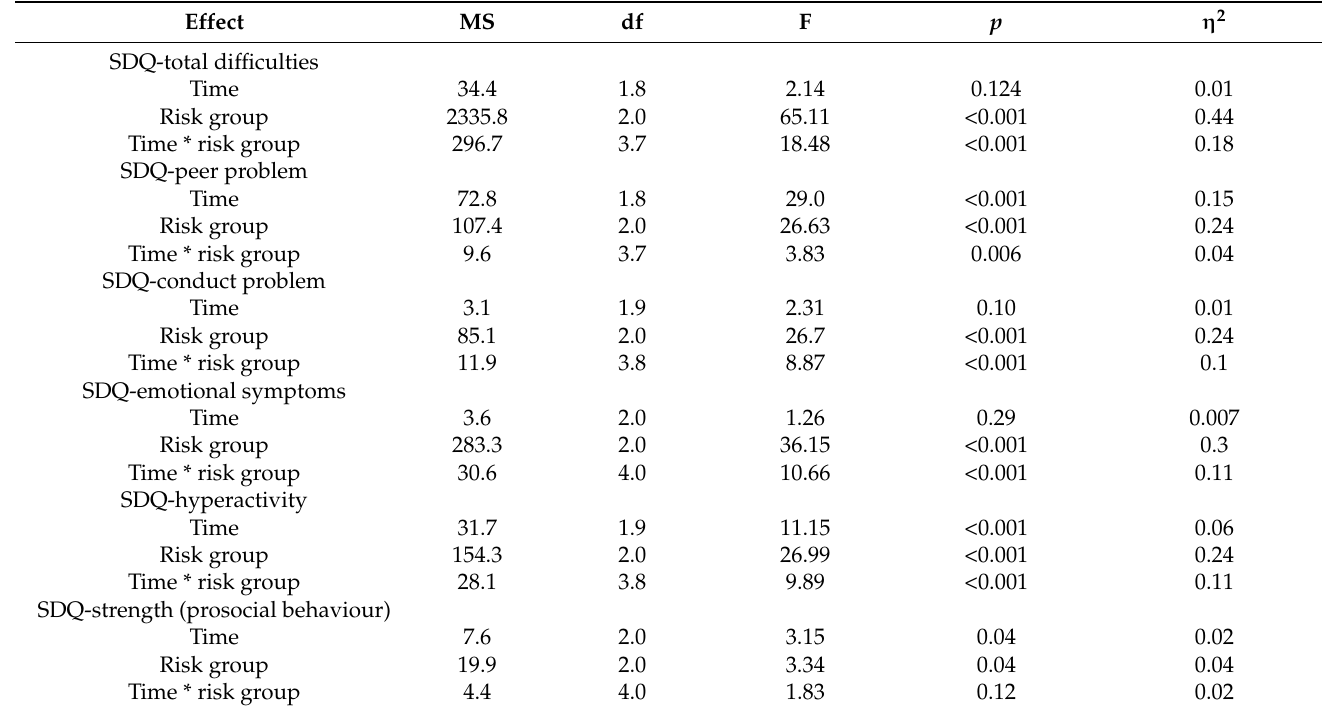
Table 4. Two-way repeated measures ANOVA for assessing the differences of SDQ scores in three time points by risk